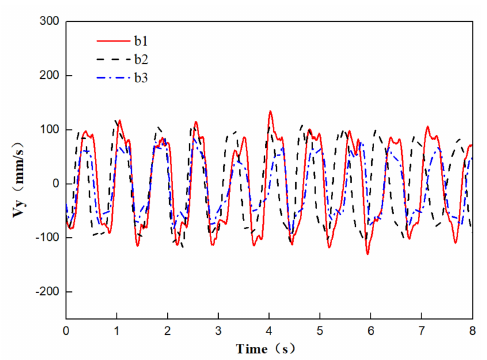
Figure 6. Variation rule of the transverse flow velocity from b1 to